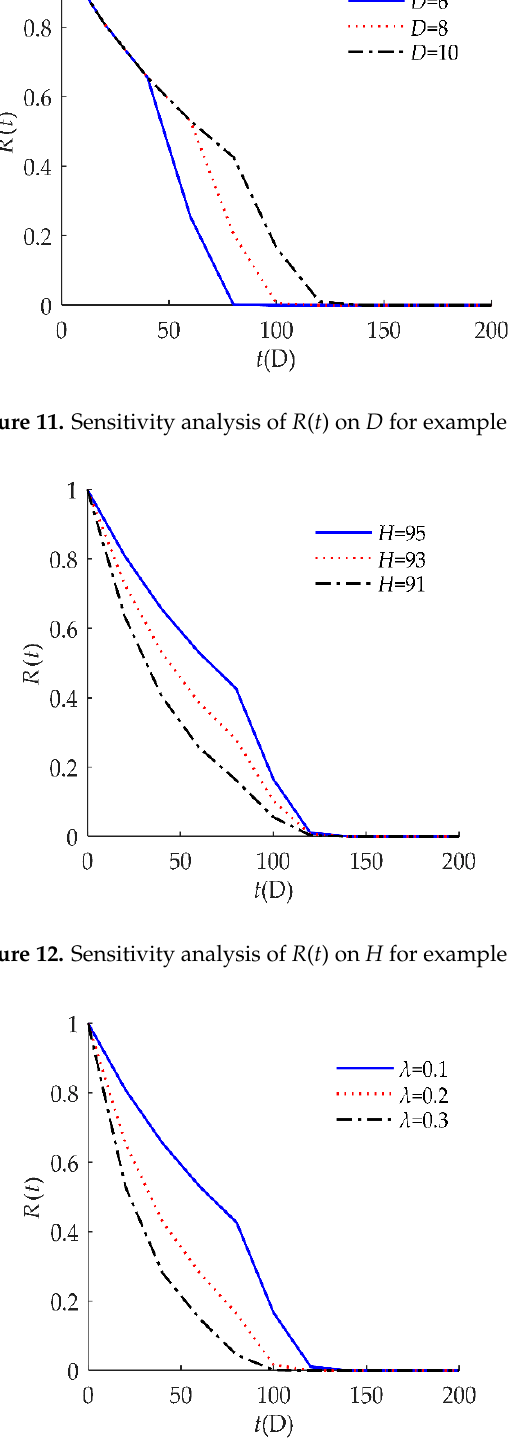
Figure 13. Sensitivity analysis of R ( t ) on λ for example II.